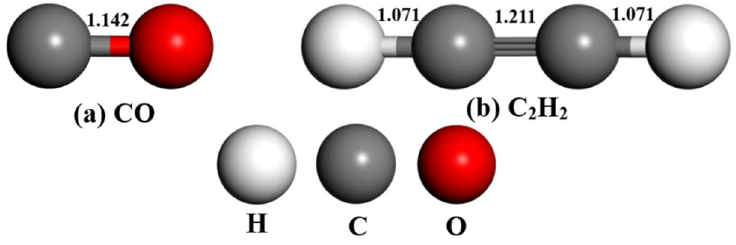
Figure 1. Geometric structures of gas molecules. ( a ) CO, ( b ) C 2 H 2